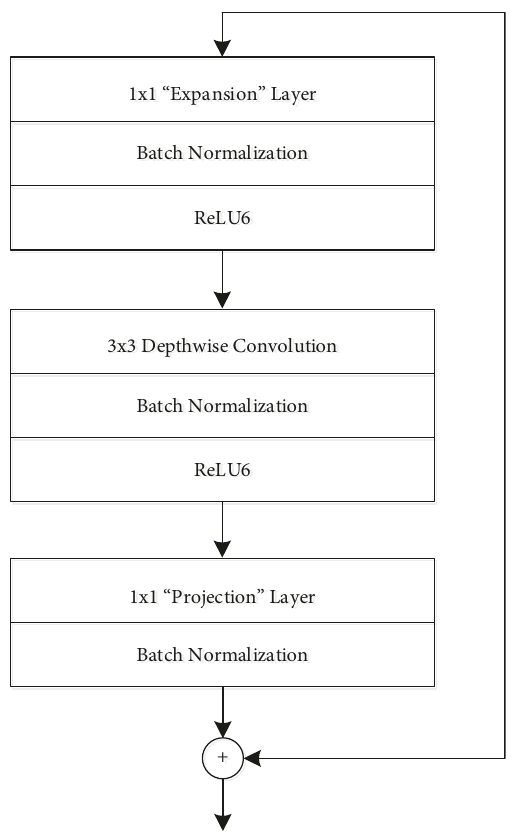
Figure 2: Inverted ResBlock network